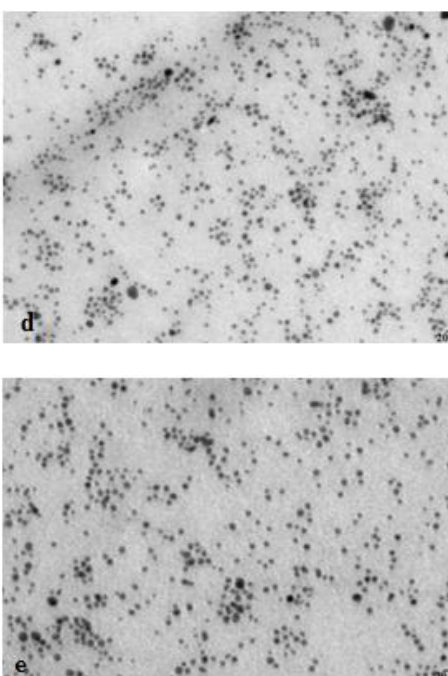
Figure 2. Transmission electron microscopy (TEM) images and corresponding histograms of silver nanoparticles at different pH values: ( a ) pH = 6; ( b ) pH = 7; ( c ) pH = 8; ( d ) pH = 9 and ( e ) pH = 10. The size, the shape and the yield of nanoparticles synthesis is also affected by the ratio of reducing agent to the metal ions. Various ratios: 1:1; 1:3; 1:7; 1:10; 1:12 and 1:15 respectively were